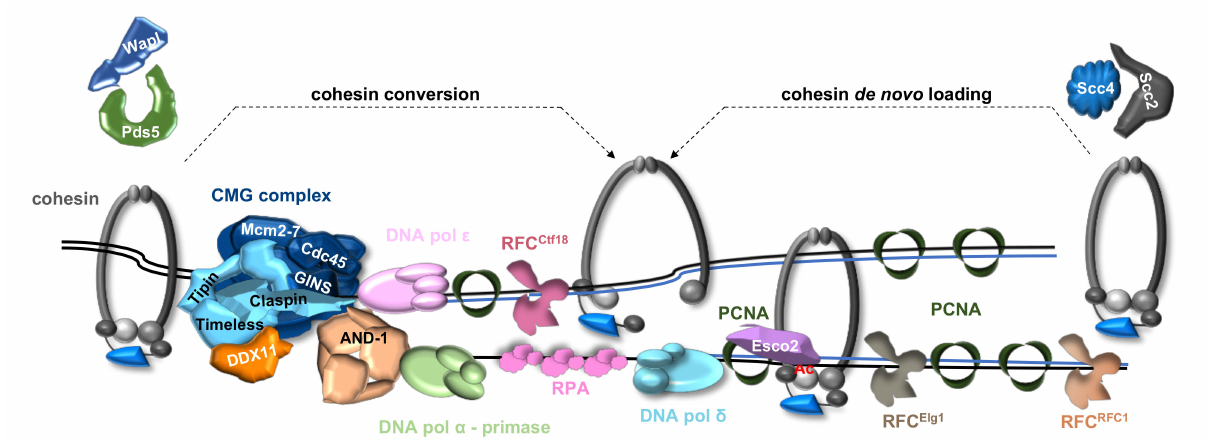
Figure 5. A hypothetical model of cohesion establishment at the human DNA replication fork. Some protein factors are omitted for simplicity (MCM10, Sororin, Fen1 and Dna2). Involvement of Pds5-Wapl and Scc2-Scc4 in cohesin conversion and de novo loading mechanism, respectively, has not yet been formally demonstrated in mammalian cells (see text for details). Ac stands for acetylation. Folding back of the lagging strand, proposed to enable DNA polymerase coupling, is not depicted here for simplicity. Relative position of the indicated protein factors is based on the structure of the yeast replisome proposed by Yeeles and colleagues